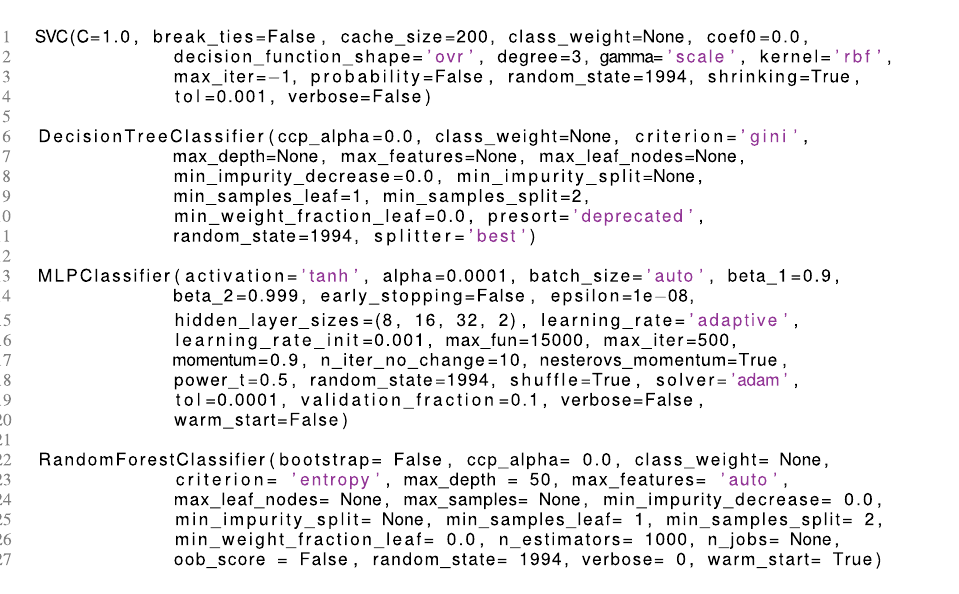
Listing 1. Hyperparameter set-up for the used